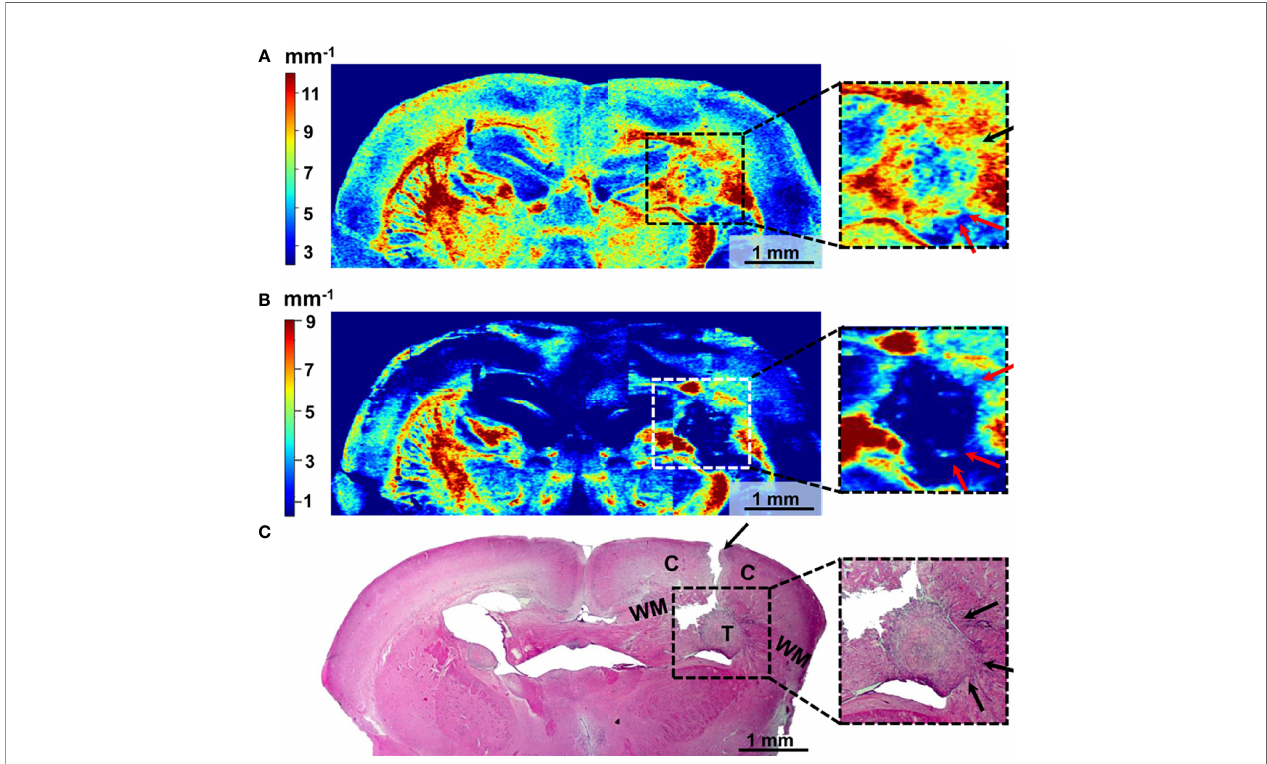
FIGURE 8 | Wide- fi eld OCT color-coded maps of the mouse brain with GBM7-Luc2-mKate2 tumor (A, B) and corresponding histology (C) . Color-coded maps based on calculation of two optical coef fi cients: attenuation in co-channel (Att co- ) (A) and in cross-channel (Att cross- ) (B) . Perifocal areas of high cancer density are marked with arrows (see enlarged fragments). T, tumor; C, cortex; WM, white